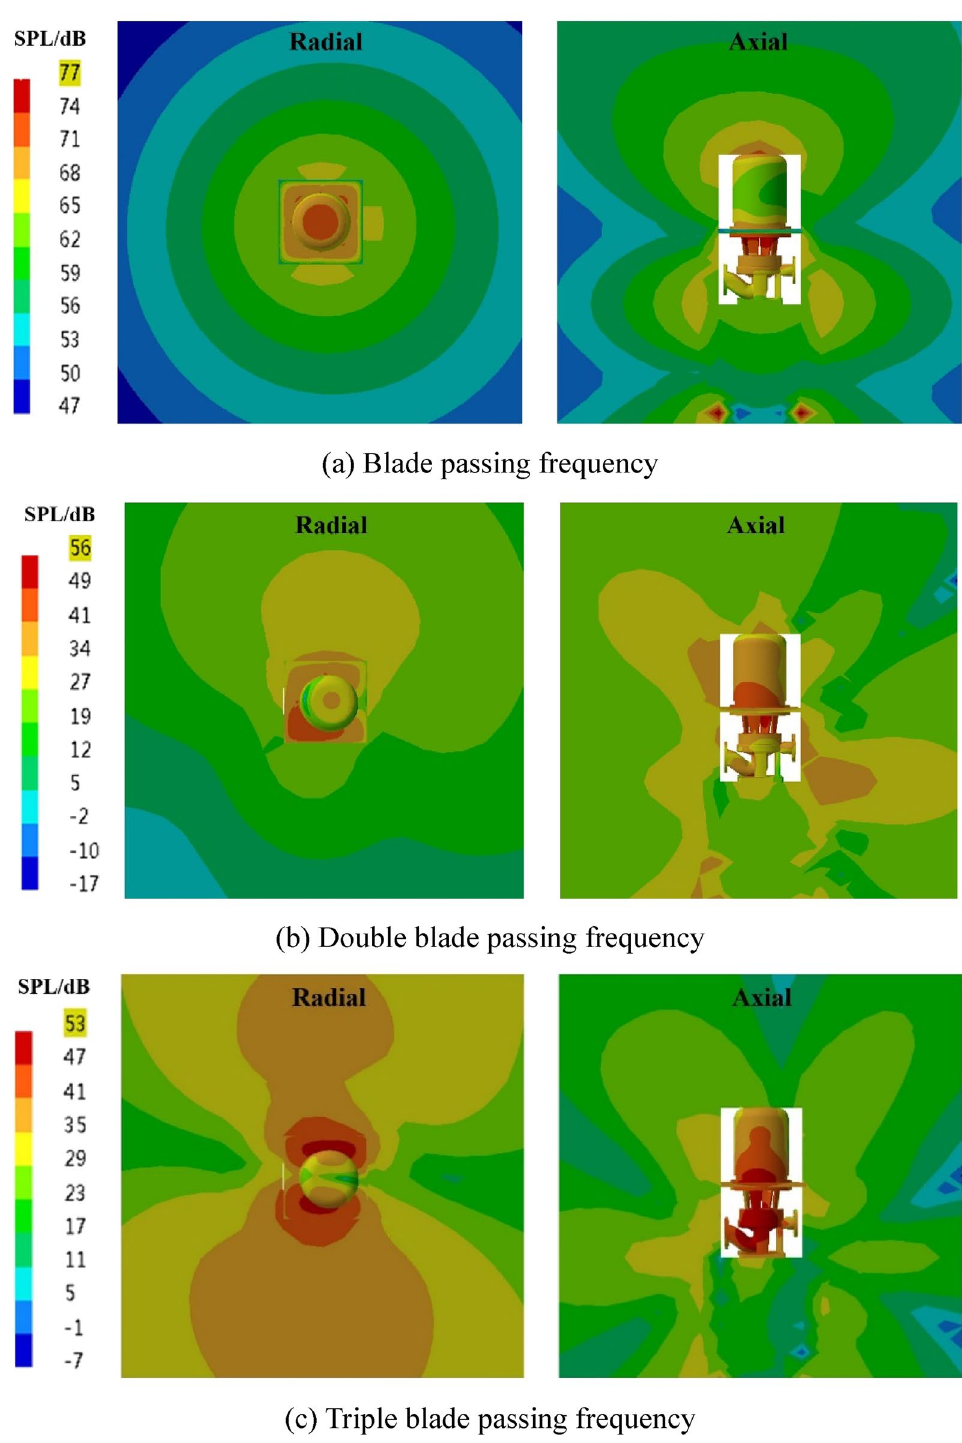
Figure 21. Pressure distribution of outfield noise by the rotating